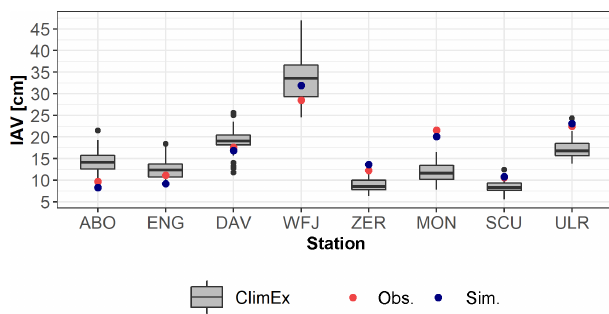
Figure 5. Interannual variability of mean winter snow depth for SNOWPACK simulations using ClimEx LE as a driver, using ob- served meteorological data as a driver (sim) and observed IAV (obs) of mean winter snow depth for the period 1984 to 2009. The boxes represent the interquartile range with the median as a horizontal line. The whiskers represent 1.5 times the interquartile range, and the dots represent outliers. See Table 1 for the abbreviations of case studies.